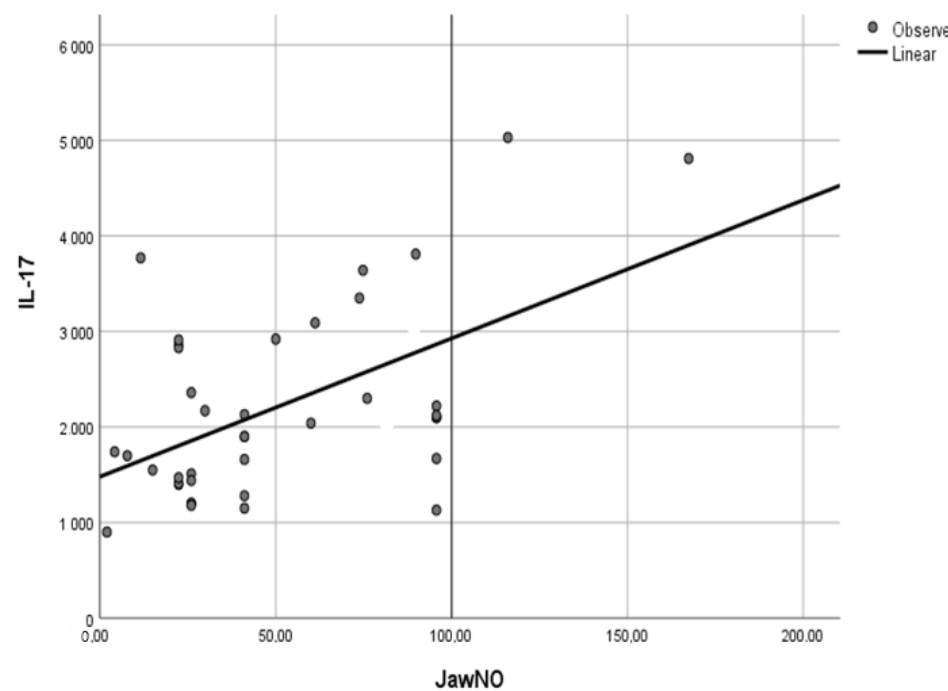
Figure 1. Correlation between IL-17 concentration in EBC and JaWNO in patients with NSCLC.